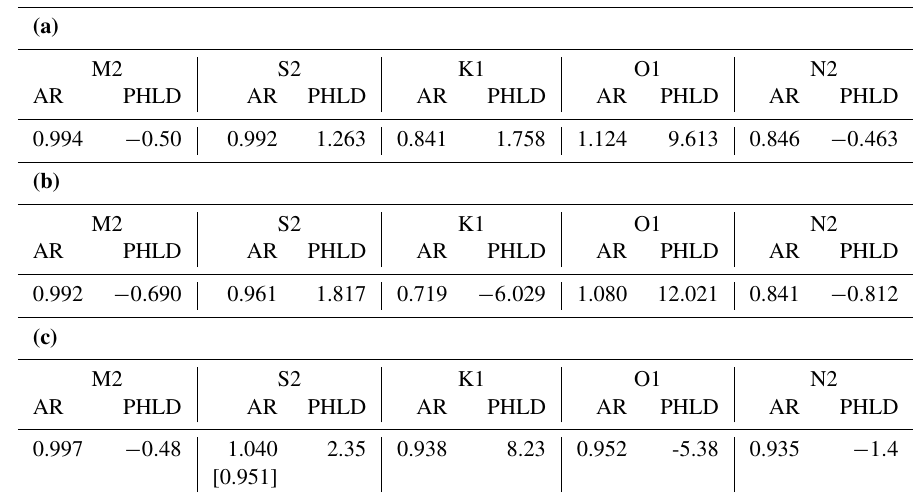
Table 2. (a) Values of ratio of historical to modern amplitudes (AR) and historical phase lag minus modern phase lag (PHLD, ◦ ) when including an 11th parameter in the fits to predicted and Maskelyne data by the first harmonic method (Sect. 3.3). (b) Values of AR and PHLD when not including an 11th parameter in the first harmonic method. (c) Values obtained using the second harmonic method (Sect. 3.4).